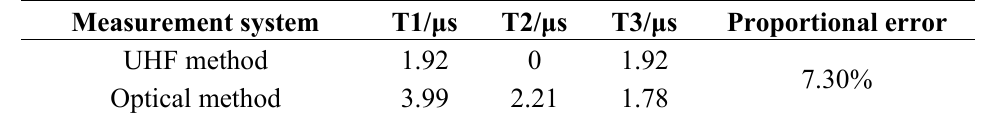
Table 3. Characteristic parameter of the PD